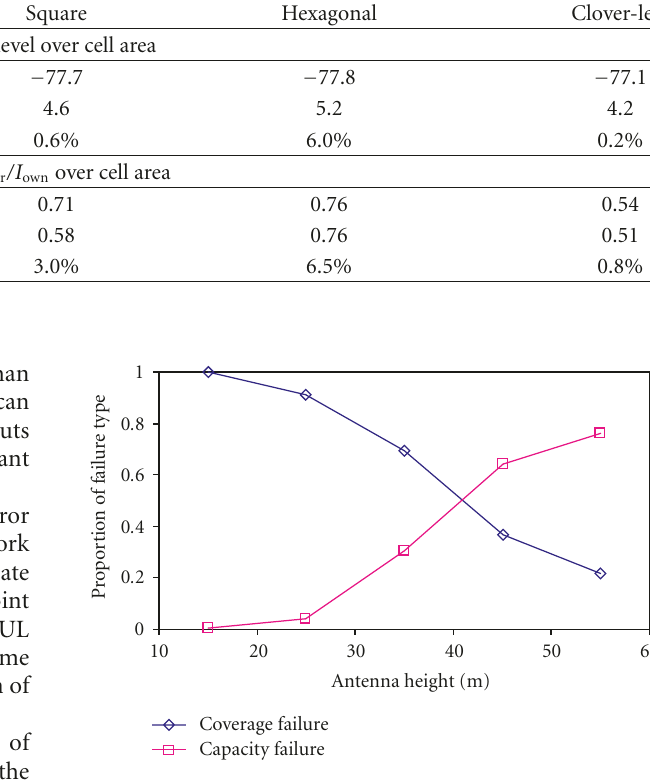
Figure 9: Relative failure type as a function of antenna height. Clover-leaf layout, cell range 800 m, optimum antenna height 32.1